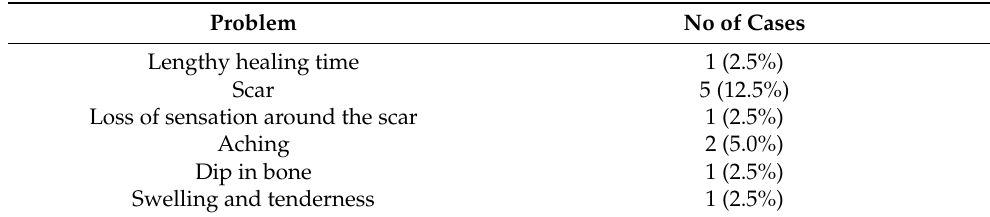
Table 6. The occurrence of late complications after the procedure of cancellous bone harvesting from the proximal